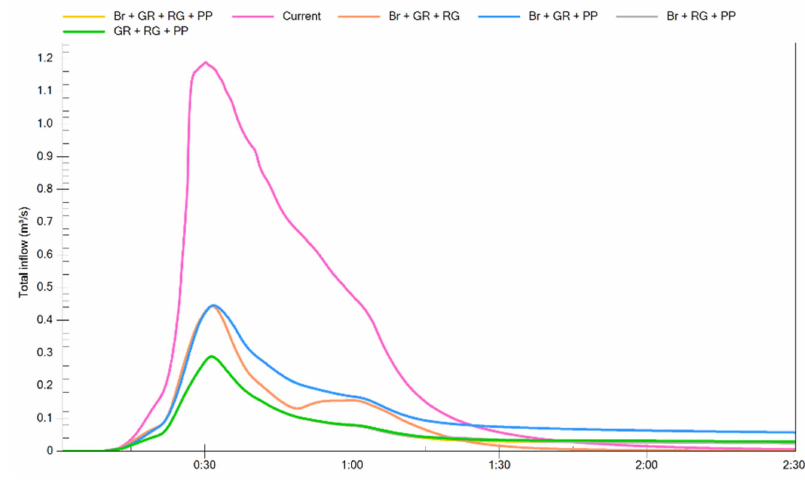
Figure 6. Performances of combinations of three and four